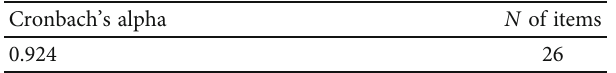
Table 6: Cronbach ’ s alpha for all variables.